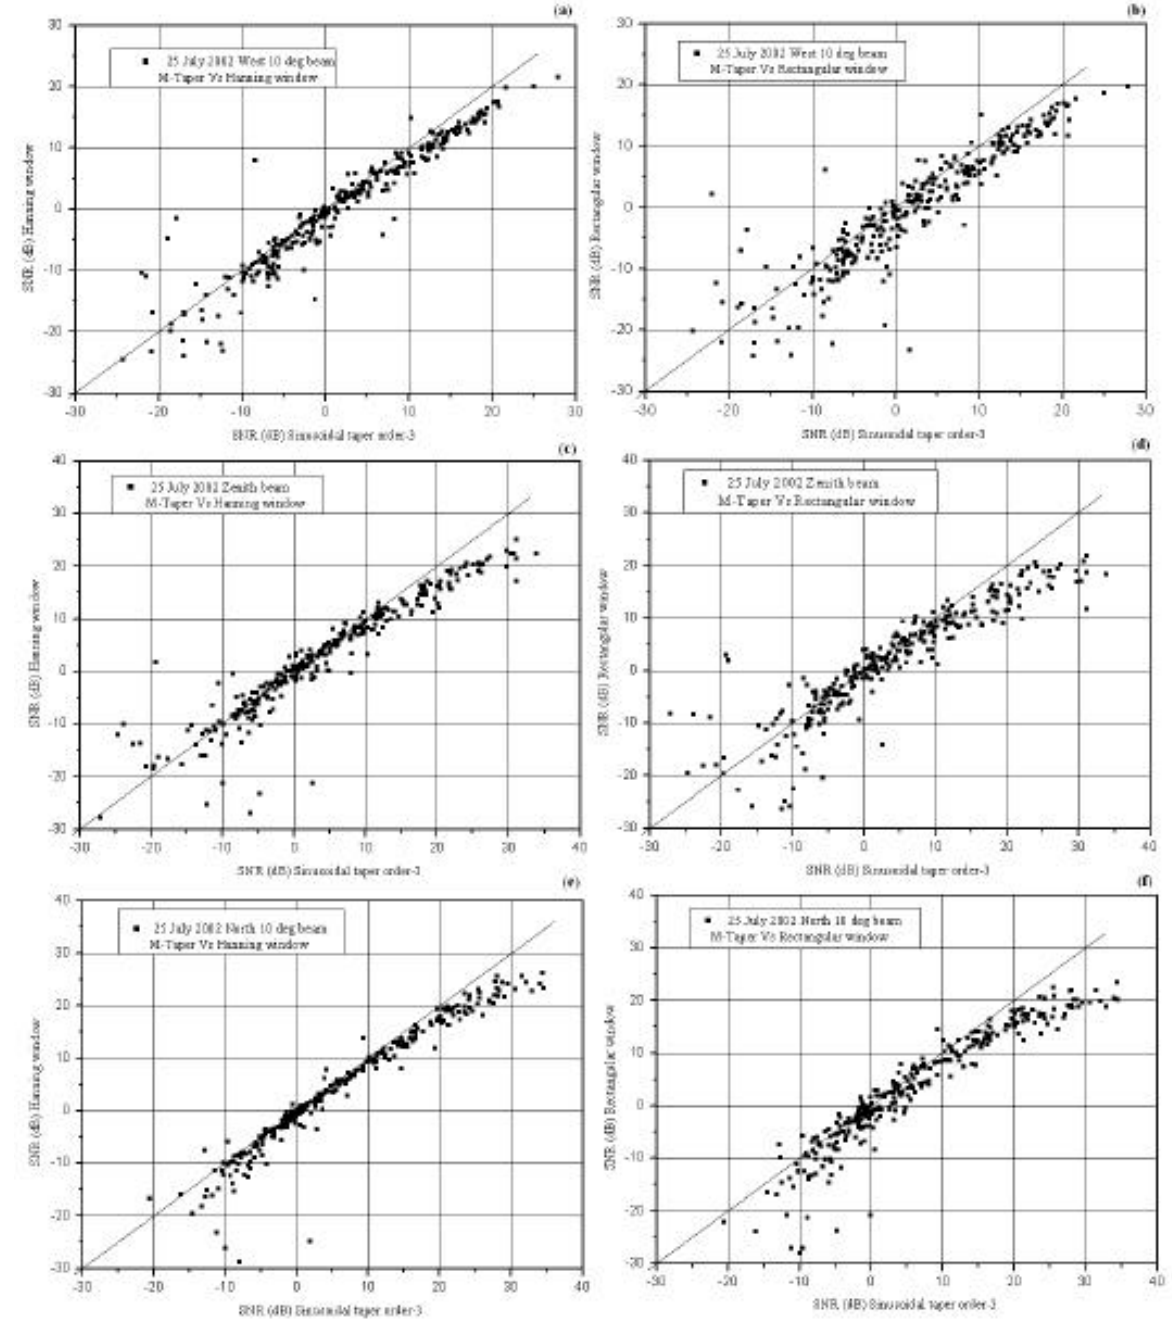
Figure 5 Fig. 5. Comparison of SNR between sinusoidal taper vs. Hanning taper, and sinusoidal taper vs. rectangular taper, (a) and (b) for west 10 ◦ beam, (c) and (d) for zenith beam, (e) and (f) for north 10 ◦ beam, respectively, observed on 25 July 2002.